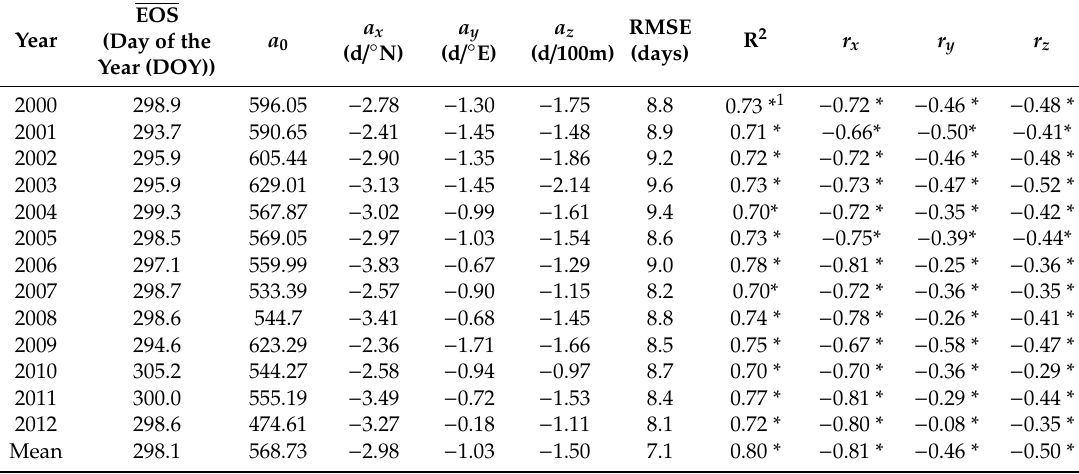
Table 3. Multiple regression equation parameters, evaluation indicators and partial correlation coe ffi cients among growing season end date, latitude, longitude and altitude. a 0 is a constant; a x , a y and a z are regression coe ffi cients denoting latitudinal sensitivity, longitudinal sensitivity and altitudinal sensitivity, respectively; EOS is the mean growing season end date across the study area; R 2 is the goodness of fit of the multiple regression model; r x , r y and r z are partial correlation coe ffi cients between the growing season end date and latitude / longitude / altitude after controlling for other two geo-location indicators,